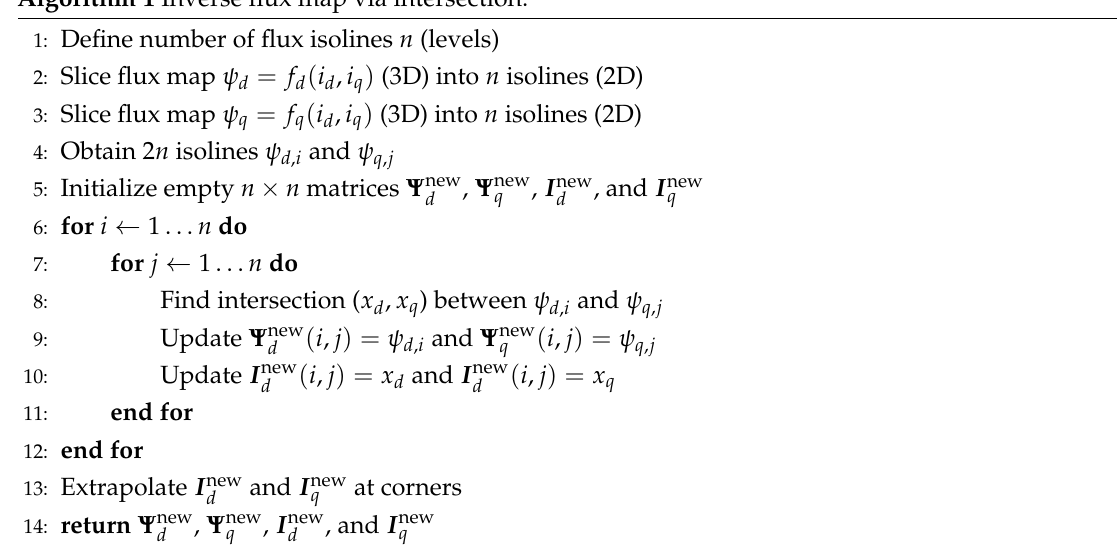
Algorithm 1 Inverse flux map via